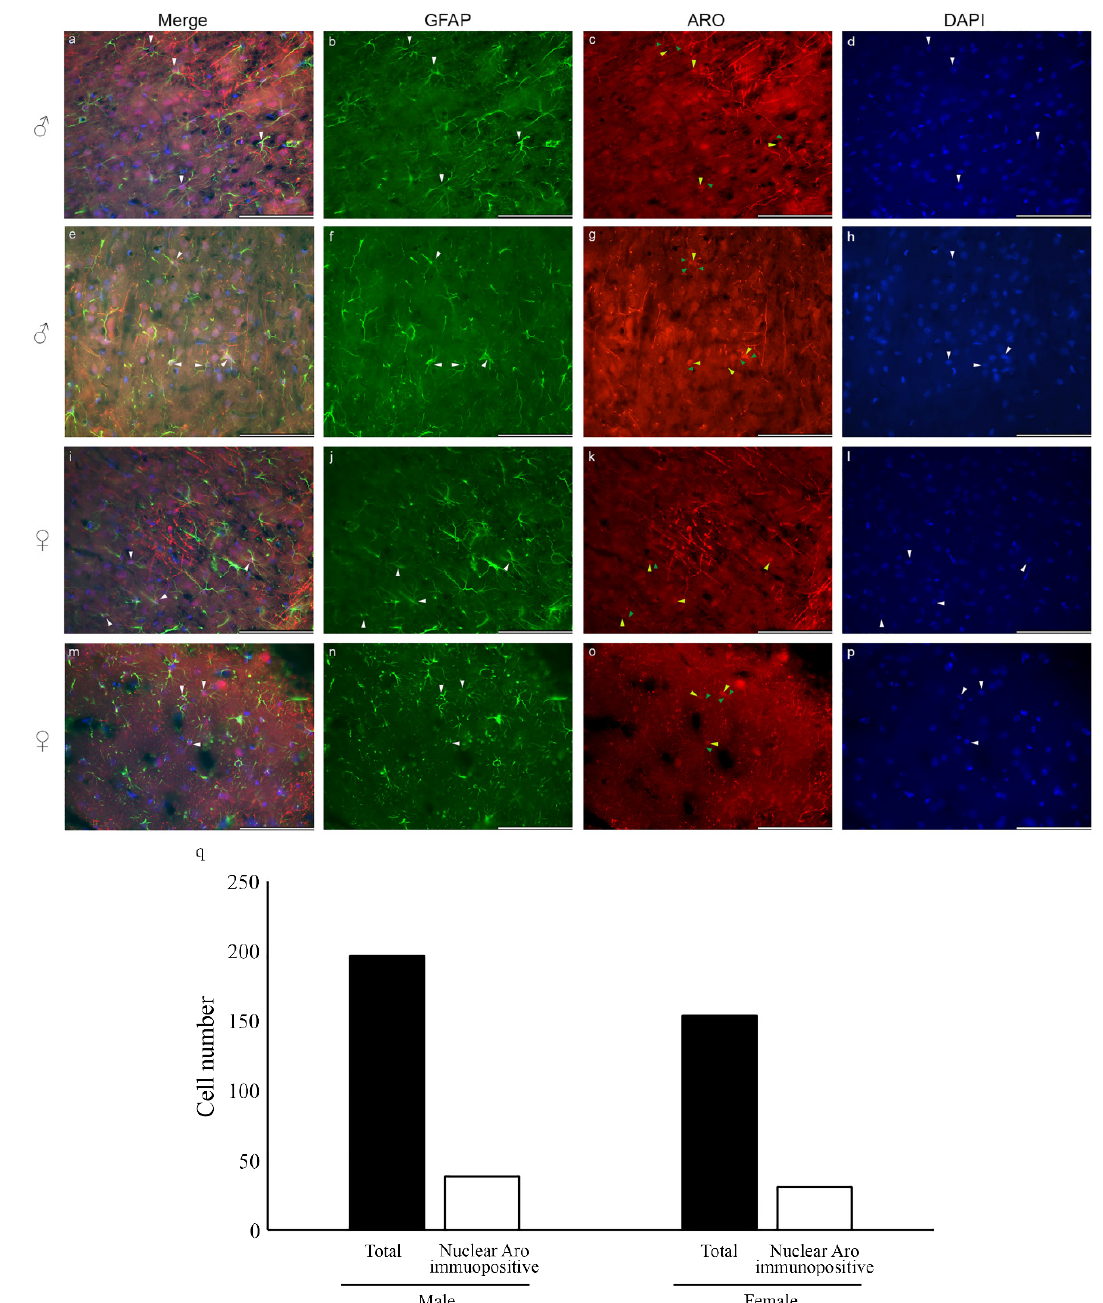
Figure 5. Localization of aromatase in astrocytes in adult rat brain sections. Nuclear (nucleus: blue) appearance of Aro enzyme (red; c , g , k , o ; yellow arrowheads) in GFAP-labelled (green) astrocytes ( a , b , e , f , i , j , m , n ; white arrowheads) is also detectable in frozen cortical tissue sections from male ( a – h ) and female ( i – p ) rats. Interestingly, the Aro immunopositive signal in the adult cortical astrocytes is abundant in the processes ( c , g , k , o ; green arrowheads), while astrocytes derived from newborn rats do not show an Aro signal in the branches. Quantitative analysis of total GFAP-positive astrocytes and nuclear Aro immunopositive astrocytes ( q ) in 10 randomly selected microscopic fields of different frozen sections from both sexes showed that the abundance of nuclear Aro immunopos- itive GFAP-labelled astrocytes is about 20% in both males (19.79%; n = 197) and females (20.13%; n = 154). Scale bar: 100 µ